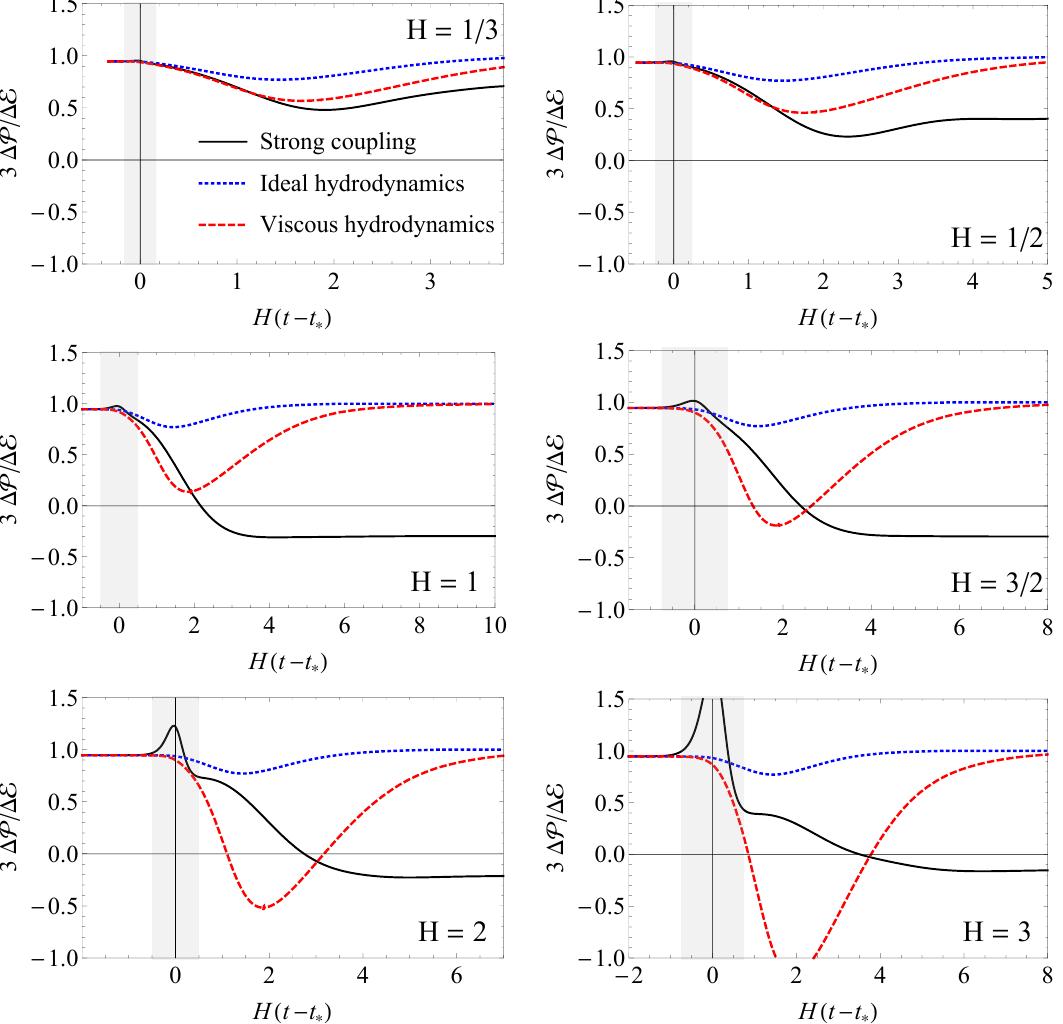
Figure 5 . Scheme-independent ratio of the excess pressure over the excess energy density defined in (4.34) as a function of time for the same initial state but different values of H . 5 The vertical grey bands indicate the duration of the quench. The solid black curves labelled “strong coupling” correspond to the exact result obtained holographically. Dotted blue and dashed red curves corre- spond to the ideal and viscous hydrodynamic approximations, respectively. In the plots with H < 1 viscous hydrodynamics provides a good approximation to the exact result for some time after the quench. During part of this period the difference between ideal and viscous hydrodynamics is of order unity, meaning that gradient corrections are as large as the ideal terms. In the plots with H ≥ 1 viscous hydrodynamics never provides a good approximation to the exact